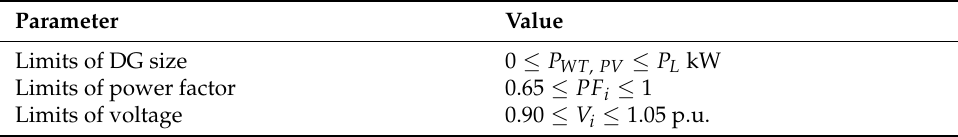
Table 4. The limitations of the system.